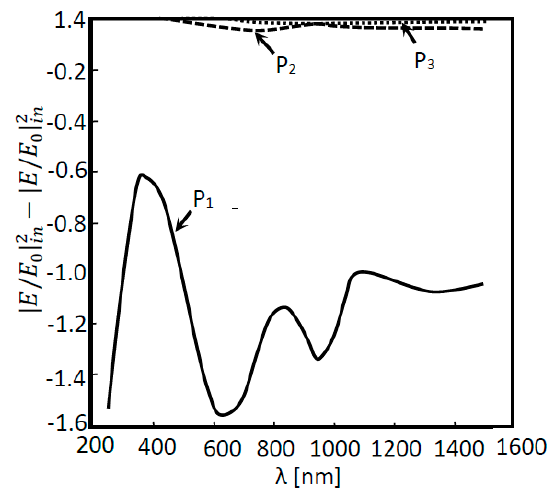
Figure 5. Absorption as a function of the wavelength for the 2D a-Si solar cell structure with the inclusion of a nanoantenna.